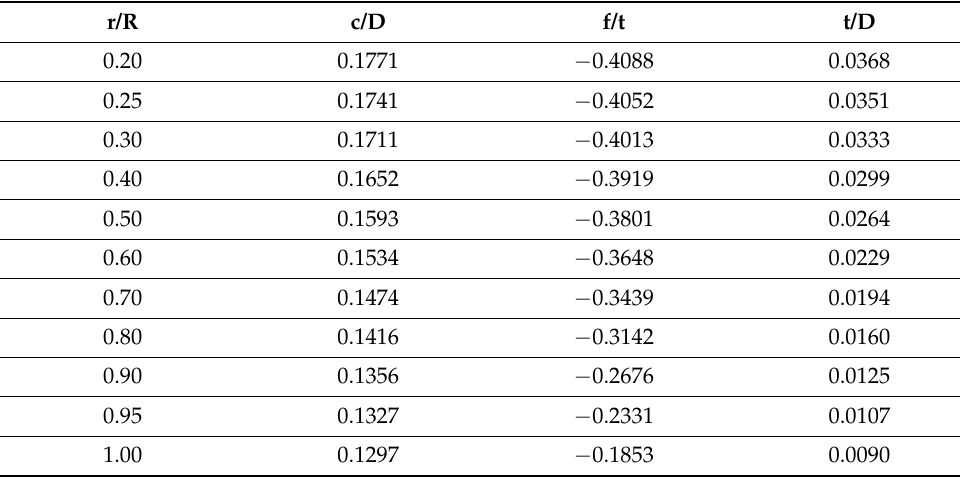
Table 6. Geometry of ring stator according to radius.